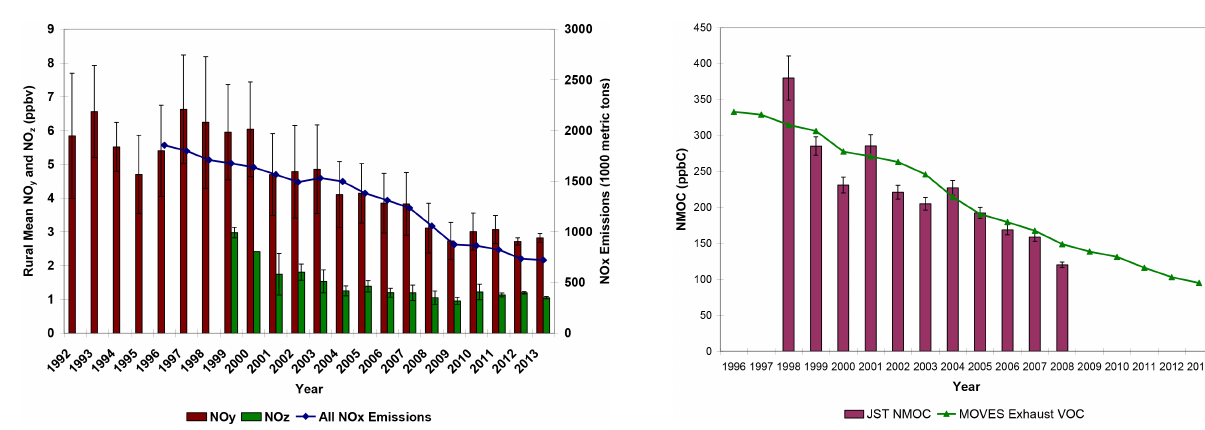
Figure 6. Mean rural NO y and NO z concentrations at the three rural SEARCH sites (CTR, OAK, YRK) and emissions of NO x from all emission sources located in Alabama, Georgia, northwest Florida, and Mississippi vs. year. Uncertainties are 1 standard error of the inter-site means. Emissions are derived from the NEIs and are up- dated from Blanchard et al. (2013c).